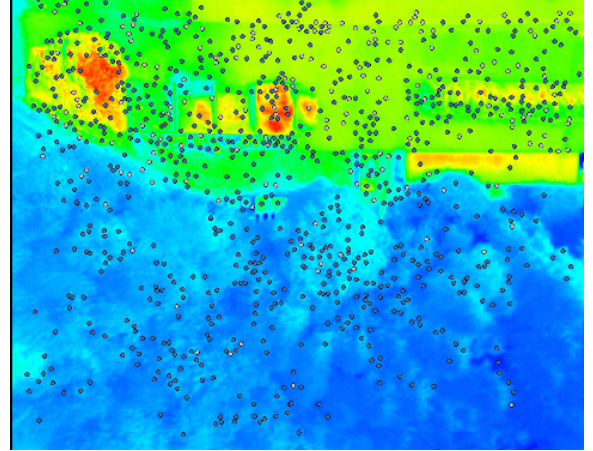
Figure 12: Thermal image at test site "WSL" with tie points (dots), temperature range: (10-29 °C), blue: deciduous forest, green: open space, orange: sheds.